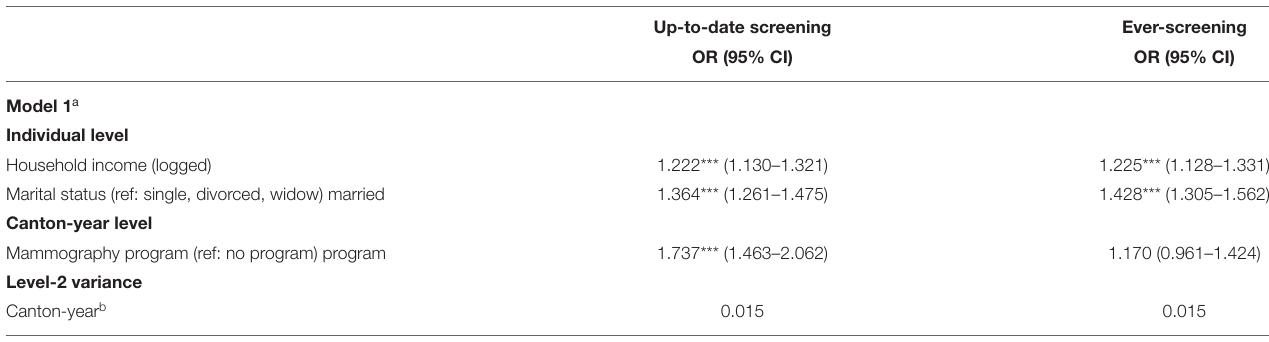
TABLE 1 | Association of up-to-date and ever-screening mammography uptake with individual-level and mammography program variables, results of logistic multilevel analysis, odds ratios and confidence intervals ( n individual = 14,267; n canton − year = 130).